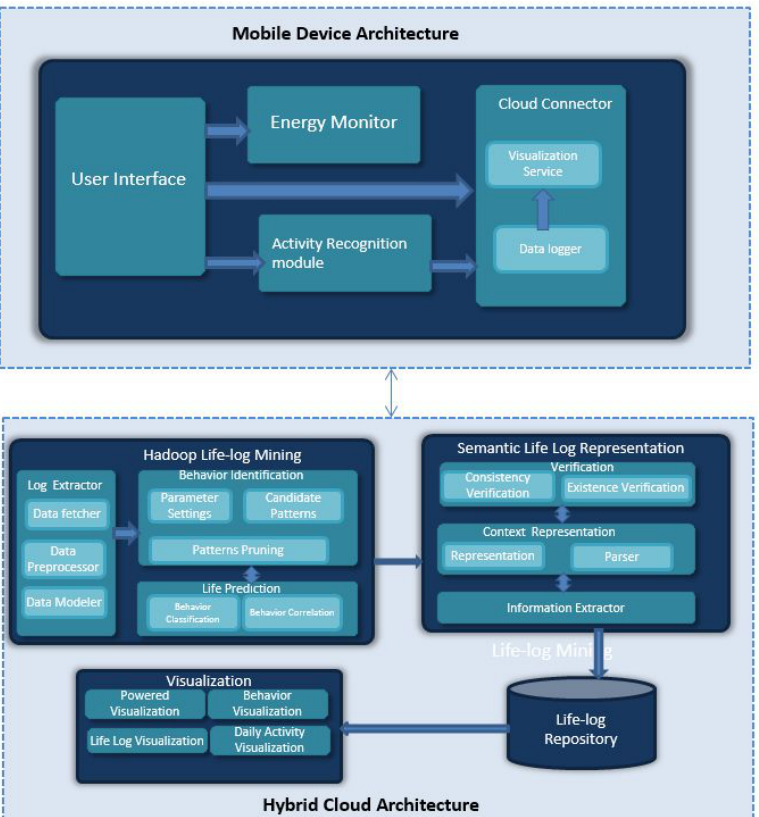
Figure 1. Main framework